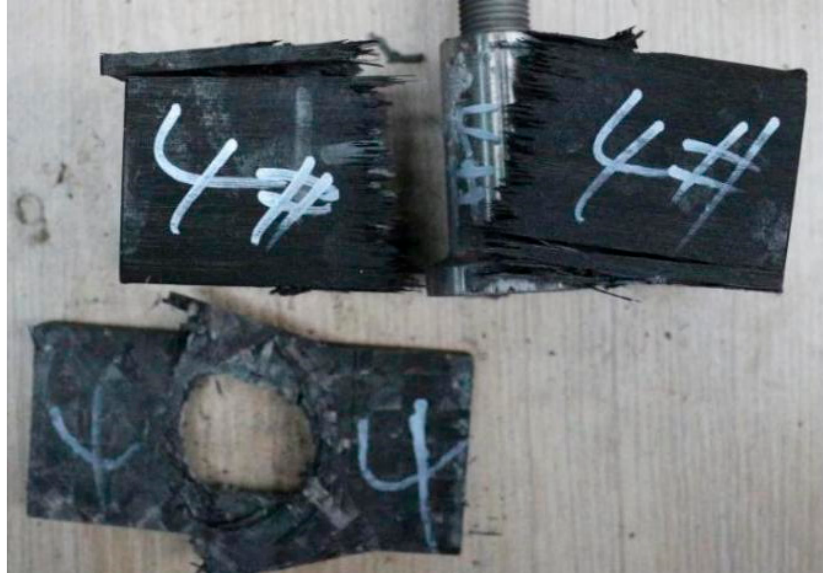
Figure 9. Fracture Figure 9. Fracture photo.